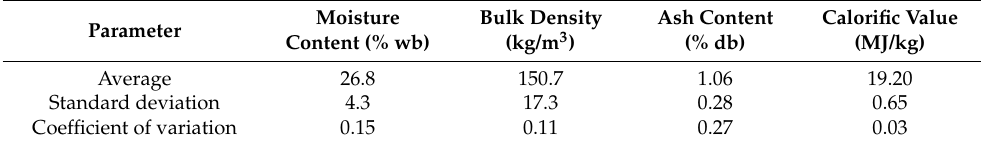
Table 1. Properties of fuel based on samples taken at University of British Columbia.